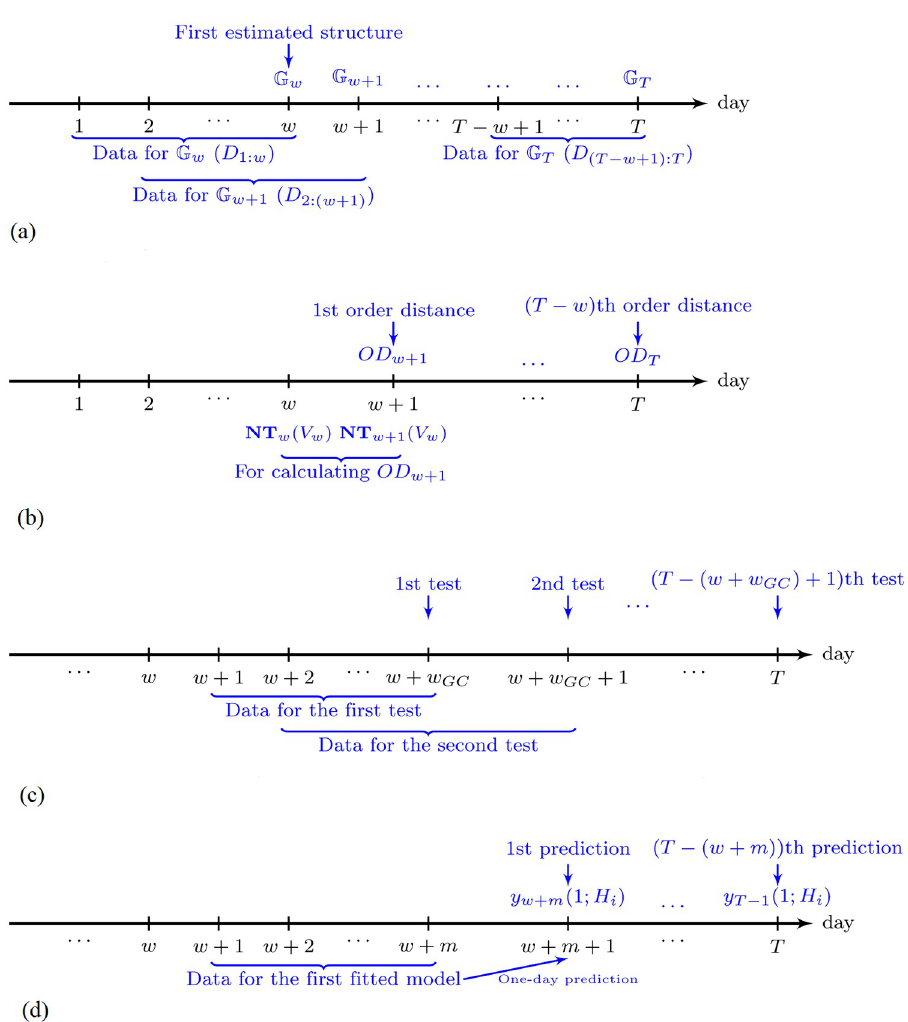
Fig 3. The timelines of the different steps in our study. (a) Timeline for the time series of network construction over theperiod under study, (b) Timeline for the calculation of the topological order distance over the period under study, (c) Timeline for the T − (w + wGC) + 1 Granger-causality tests over the period under study, and (d) Timeline for the LASSO regression prediction for the hypothesis H i over the period under study, where i 2 {0, 1 a , 1 b ,